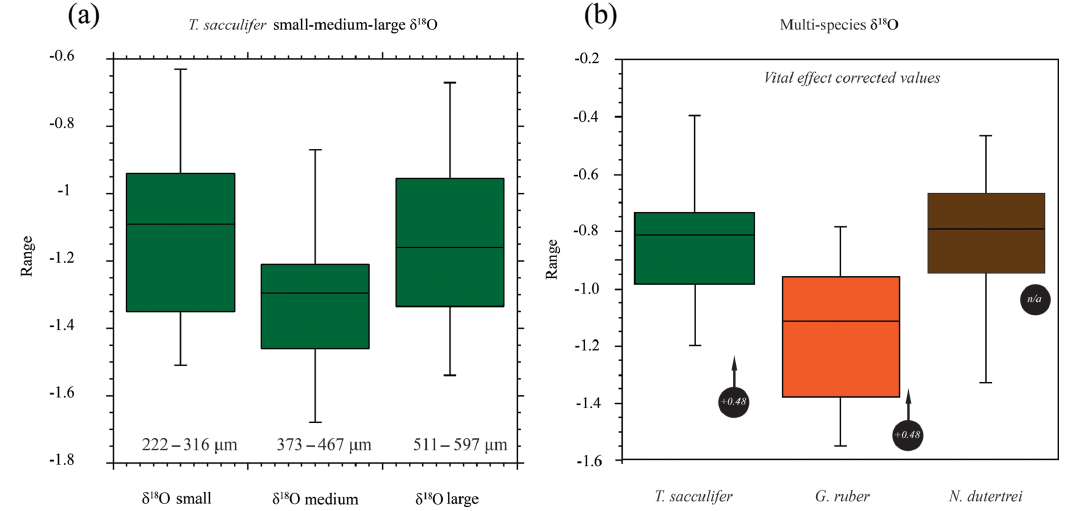
Figure 6. Box plots of the oxygen isotope values ( δ 18 O) vs. size and for different species of planktonic foraminifera. (a) Small, medium and large (see the text for definitions of sizes represented; note the uneven size interval). (b) The (right-hand side) box plots are the range in oxygen isotopes corrected for vital effects (circles with arrows) calculated from in situ water sampling (plankton pump and plankton tow; Frank Peeters, unpublished data). The central bar of each box represents the median. Table 2. Results of the ANOVA test for size fractions. Comparison of the means of the three different size classes: small, medium and large. Analysis of variance results Source Degrees of freedom (DF) Sum of squares (SS) MS F -value P -value Total 40 2.49 2 Error 38 Tukey’s all pair comparison Mean